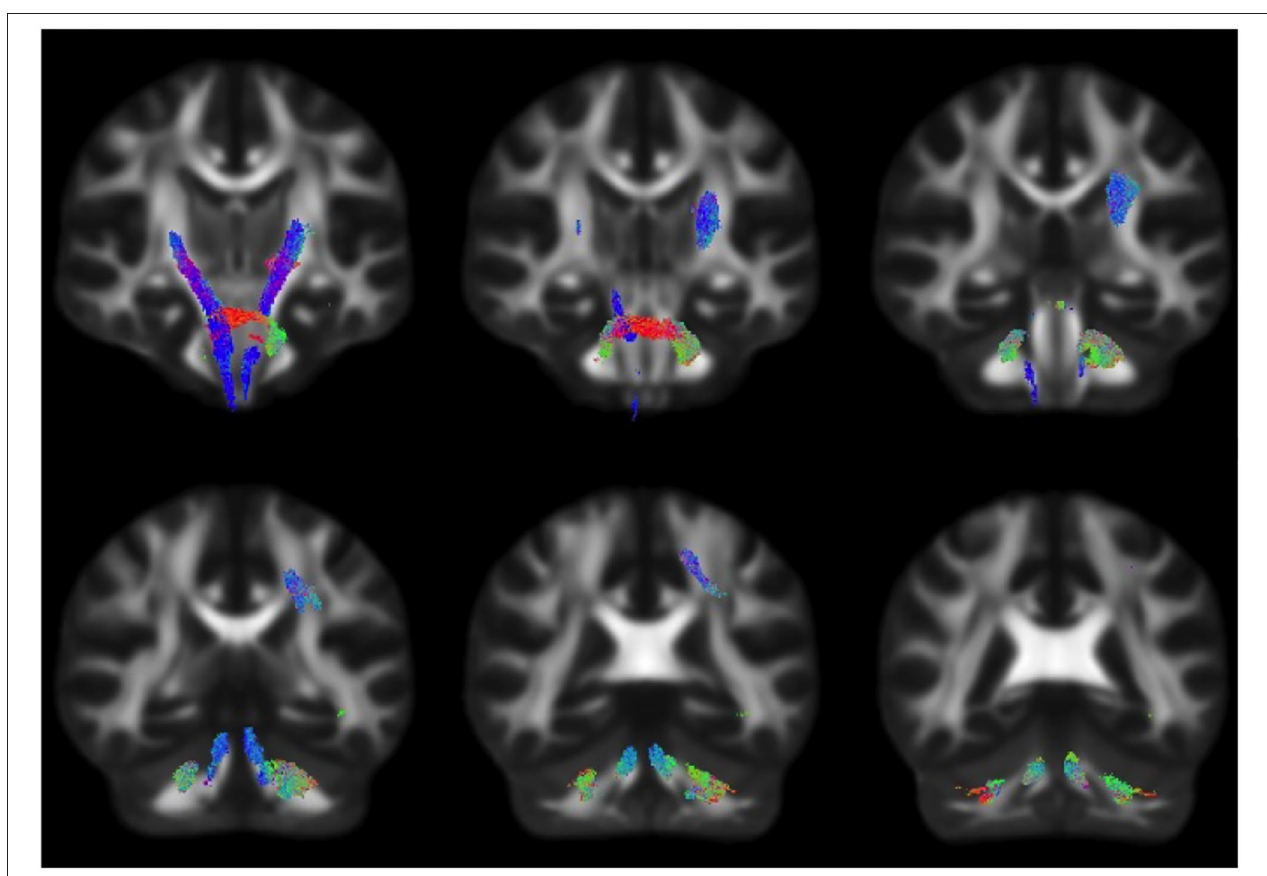
FIGURE 2 | Fiber tract-specific logFC decreases in HIV infection, colored by direction. Streamlines were cropped from the template tractogram to include only significant fixels (FWE-corrected p < 0.05) for which the logFC metric is decreased in the HIV + compared to HIV– individuals. Significant streamlines are shown across coronal slices and colored by direction (anterior–posterior, green; superior–inferior, blue; left–right, red).